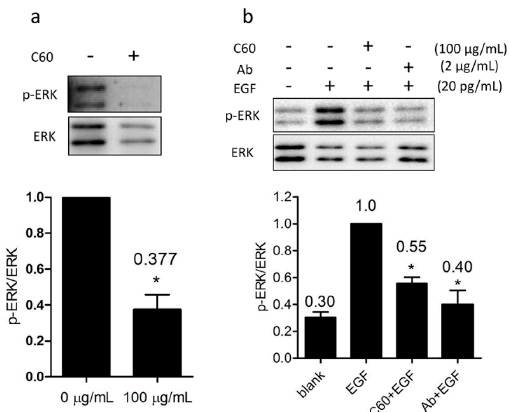
Figure 5. Fullerenol reduces extracellular signal-regulated kinase 1 and 2 (ERK1/2) activation by blocking epidermal growth factor receptors (EGFRs). Freshly isolated oocyte-granulosa cell complexes (OGCs) were cultured in M2 medium with 100 μ g/mL fullerenol (presented as C60) and 2 μ g/mL EGFR antibody (presented as Ab) for 2 h, and then granulosa cells were harvested after removing oocytes following continuous stimulation with or without EGF (20 pg/mL, 10 min). ( a ) Fullerenol treatment (100 μ g/mL) significantly reduced ERK1/2 activation in granulosa cells; ( b ) Fullerenol or extracellular domain targeted anti-EGFR antibody pretreatment (100 μ g/mL for 2 h) reduced EGF-induced-ERK1/2 activation. Mean values are presented in the quantitative image. Ab, extracellular domain targeted anti-EGFR antibody. At least three individual experiments were performed. Data are shown as mean ± standard deviation (SD); * p < 0.05 compared with the control.